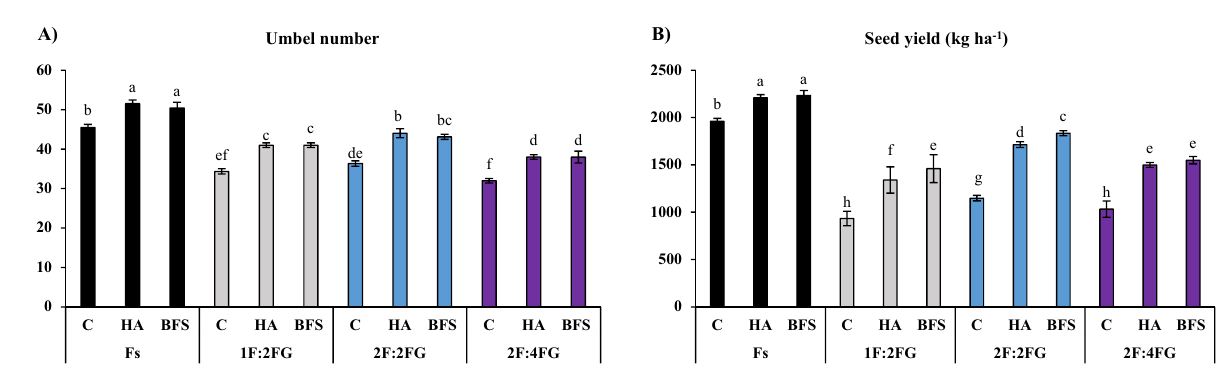
Figure 2. Means comparison for the interaction effect of fertilization [C (control), HA (humic acid), BFS (biofertilizers)] and different cropping patterns [Fs (fennel sole cropping), 1F:2FG, 2F:2FG, 2F:4FG (ratios of fennel and fenugreek in the intercropping patterns)] on umbel number ( A ) and seed yield ( B ) of fennel. Different lower-case letters above the bars indicate significant (p ≤ 0.05)